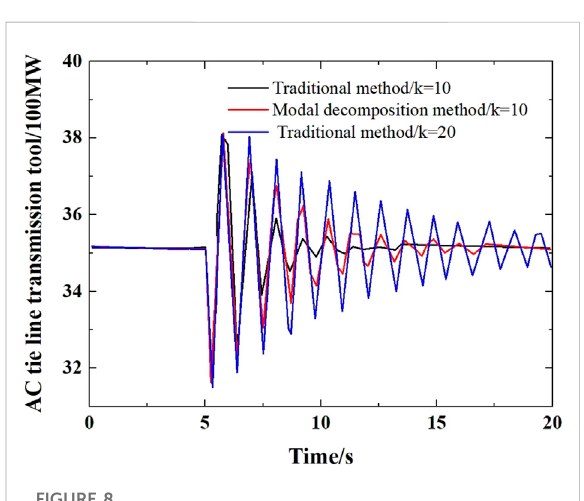
FIGURE 8 Power oscillations of AC tie lines with different controllers